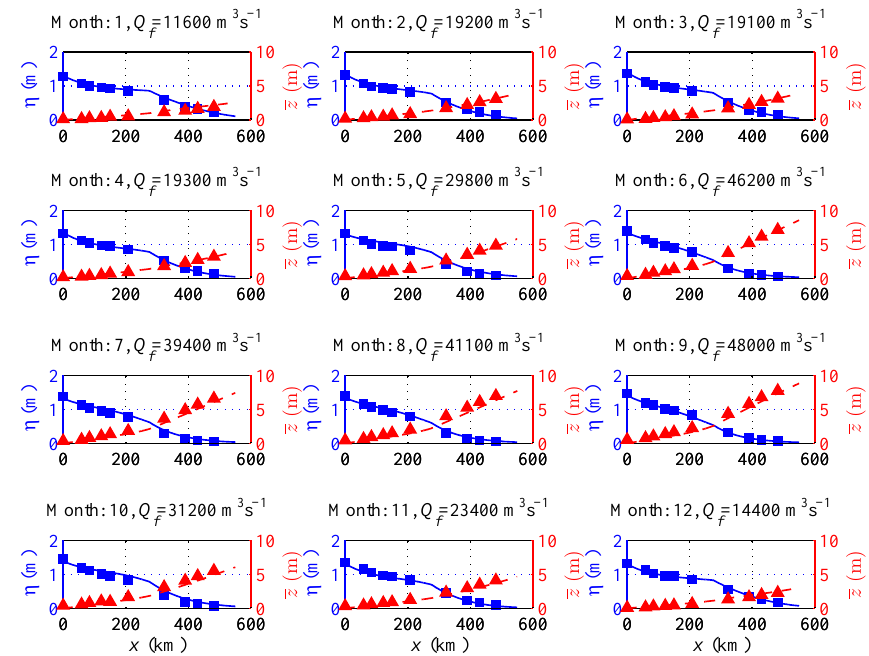
Figure 5. Comparison between analytically computed monthly averaged values (left-hand vertical scale: tidal amplitude; right-hand vertical scale: residual water level) and observations in the Yangtze estuary in 2005.